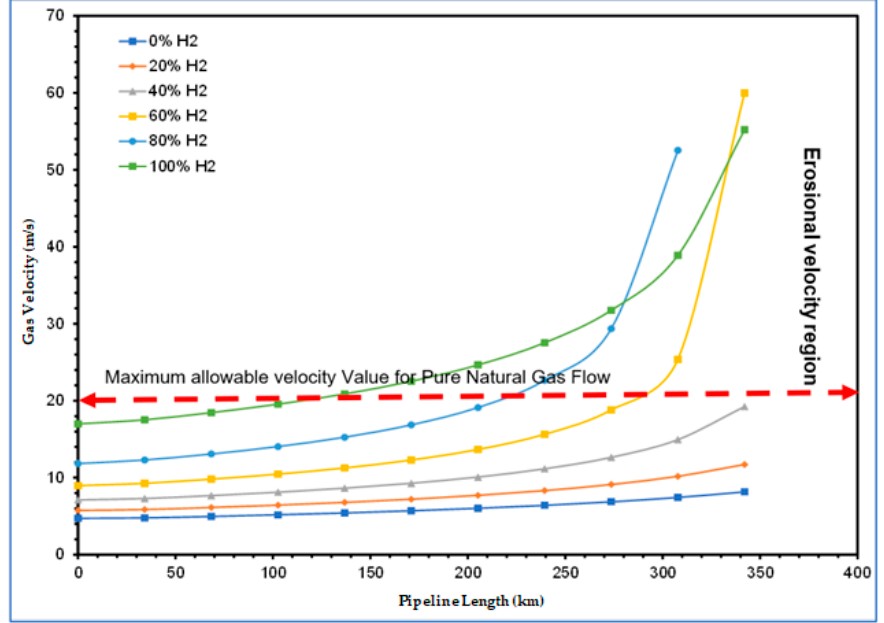
Figure 10. Velocity profile for gas pipeline flow of hydrogen blends (60 bar, 303.15 K). Once hydrogen is injected into the natural gas stream, even at 20% proportion, a gradual increase in velocity was observed due to the decrease in the density of the com ‐ bined mixture. This trend continued for blends up to 40%, with the maximum velocity still within the allowable velocity limits for the entire 342 km pipe length. On the other hand, 60% hydrogen blends with natural gas will move the velocity–length graph into the region of erosional velocity limit for a pipe length as short as 290 km, as shown in Figure 10. This makes it necessary for compression or looping at that distance, which comes with additional cost to the energy transition scheme. To better understand the nature of the hydrogen blends vis ‐ à ‐ vis the high ‐ velocity profiles that pose safety concerns in the pipeline beyond the acceptable erosional limit, the nature of the density changes for each blend provides better insights. This is shown in Figure 11, where each arrow ‐ headed dashed line shows the range of change in density for the curve with the same colour.